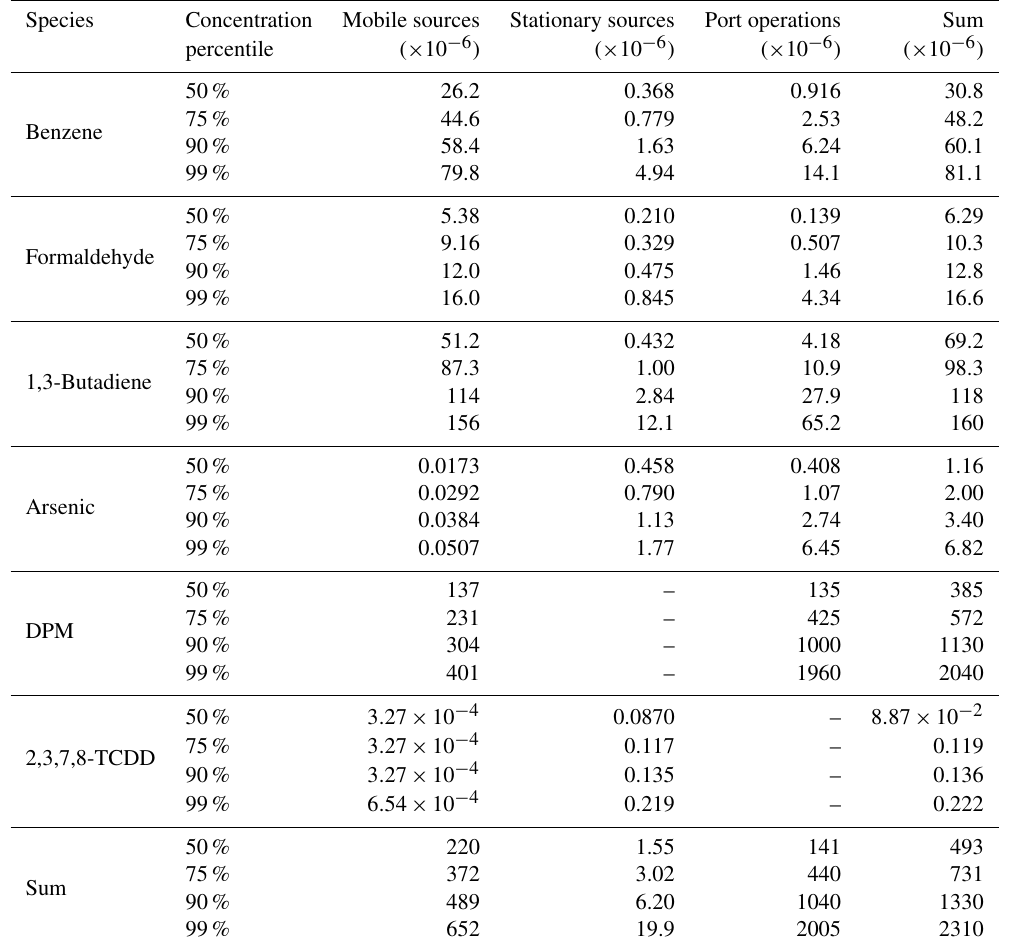
Table 2. Cancer risk from different emission sources and species for different percentile concentrations.